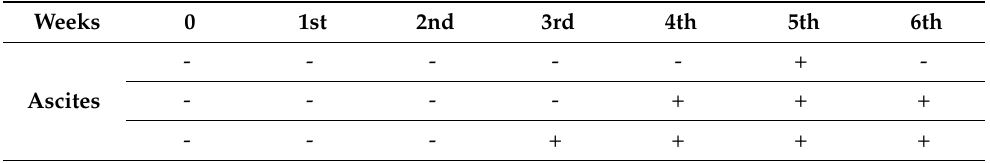
Figure 5. Serological indices of normal versus CCL4/urethane treated rats from week one to week six. Alkaline Phosphatase (ALP) ( a ), Total Bilirubin (TB) ( b ), Aspartate transaminase (AST) ( c ), Alanine transaminase (ALT) ( d ). Table 1. Weekly comparison of Ascites of normal versus CCL4/urethane treated